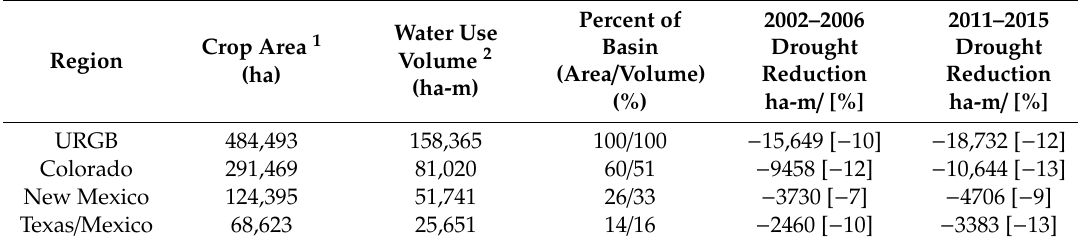
Table 3. Irrigated area crop water use volume and changes by region: (1) 1986–2015 average water use, (2) crop area (ha), (3) area and water use percentage of the basin, (4) the 2002–2006 average water use reduction (% and volume), and (4) the 2011–2015 average water use reduction from 30-year average (volume in ha-m and in %).